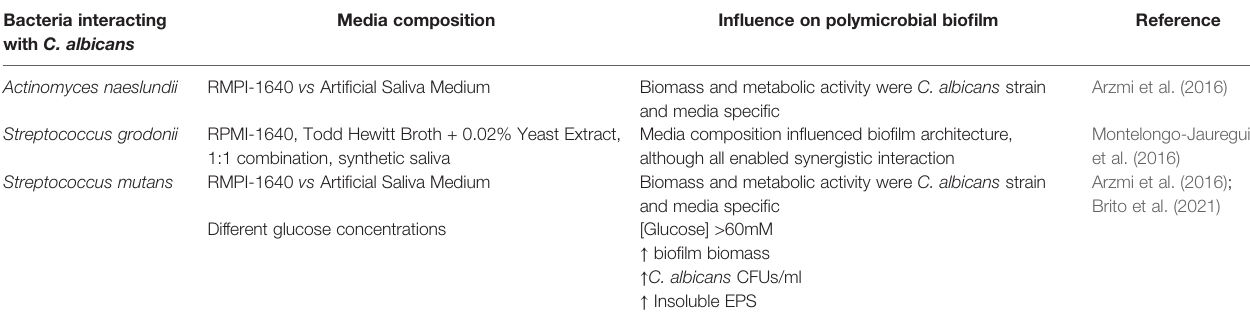
TABLE 1 | Summary of the recent studies highlighting the impact of different media on Candida albicans containing polymicrobial bio fi lms. Bacteria interacting with C.